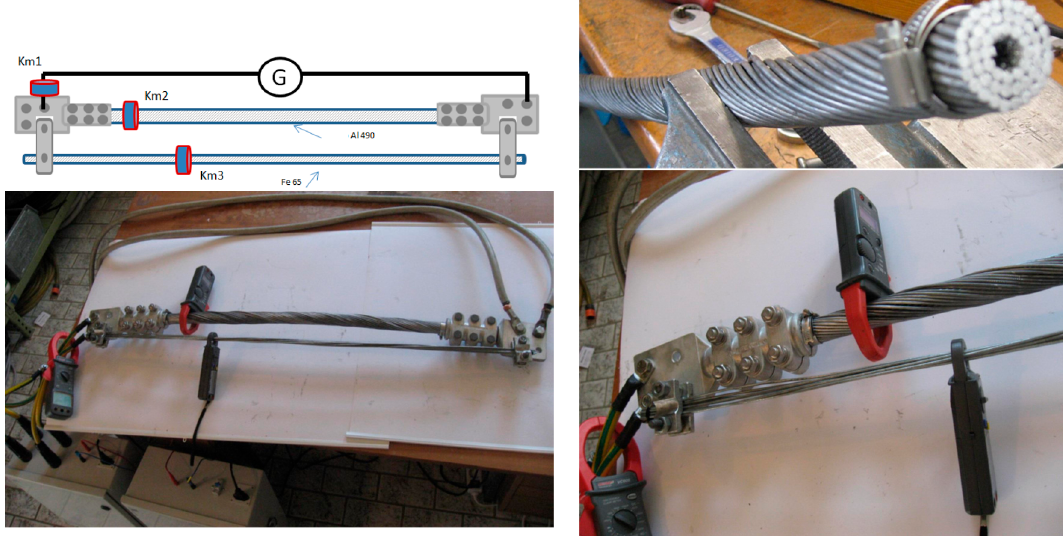
Figure 10. Measurement of current in parallel binding of aluminum coat and steel core.